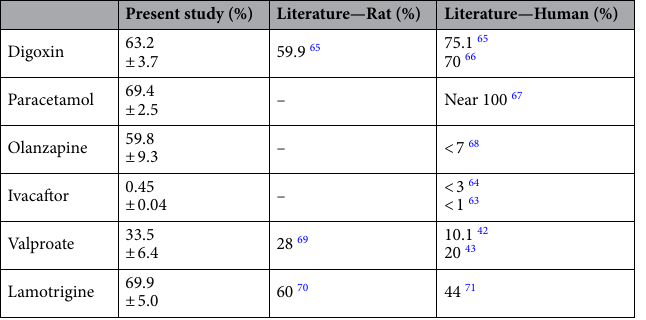
Table 4. Comparison of free fraction of drugs in plasma of humans and rats. Protein-free fraction/whole plasma concentration ratios (%) in plasma of non-pregnant female adult rats in the present study and from